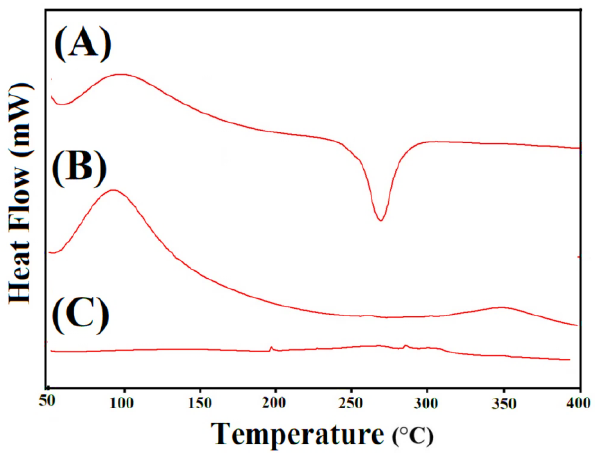
Figure 7. DSC thermogram of ( A ) Cs, ( B ) Sps, and ( C ) Cs/SpsCpAca hydrogel.